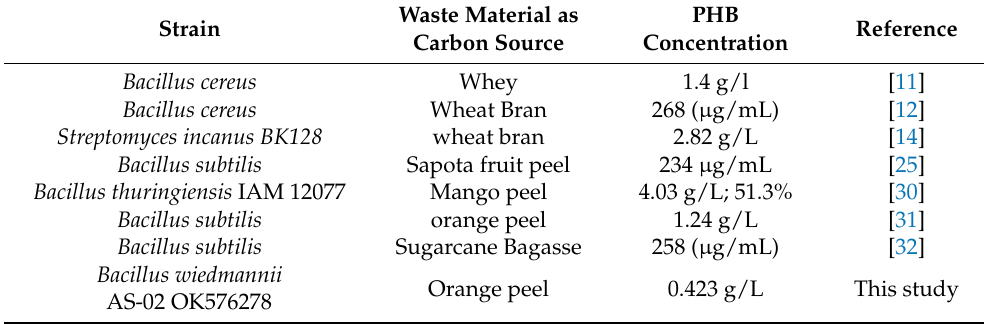
Figure 12. Production of PHB from agro-waste material by Bacillus wiedmannii strain, p. referring to peel. The ANOVA test was carried out by using SPSS 21 comparisons among means ± SE standard error ( n = 3); different letters show significance at p = 0.05 level based on Duncan’s multiple range test. Table 6. Comparison of PHB production by different bacteria using different waste materials.